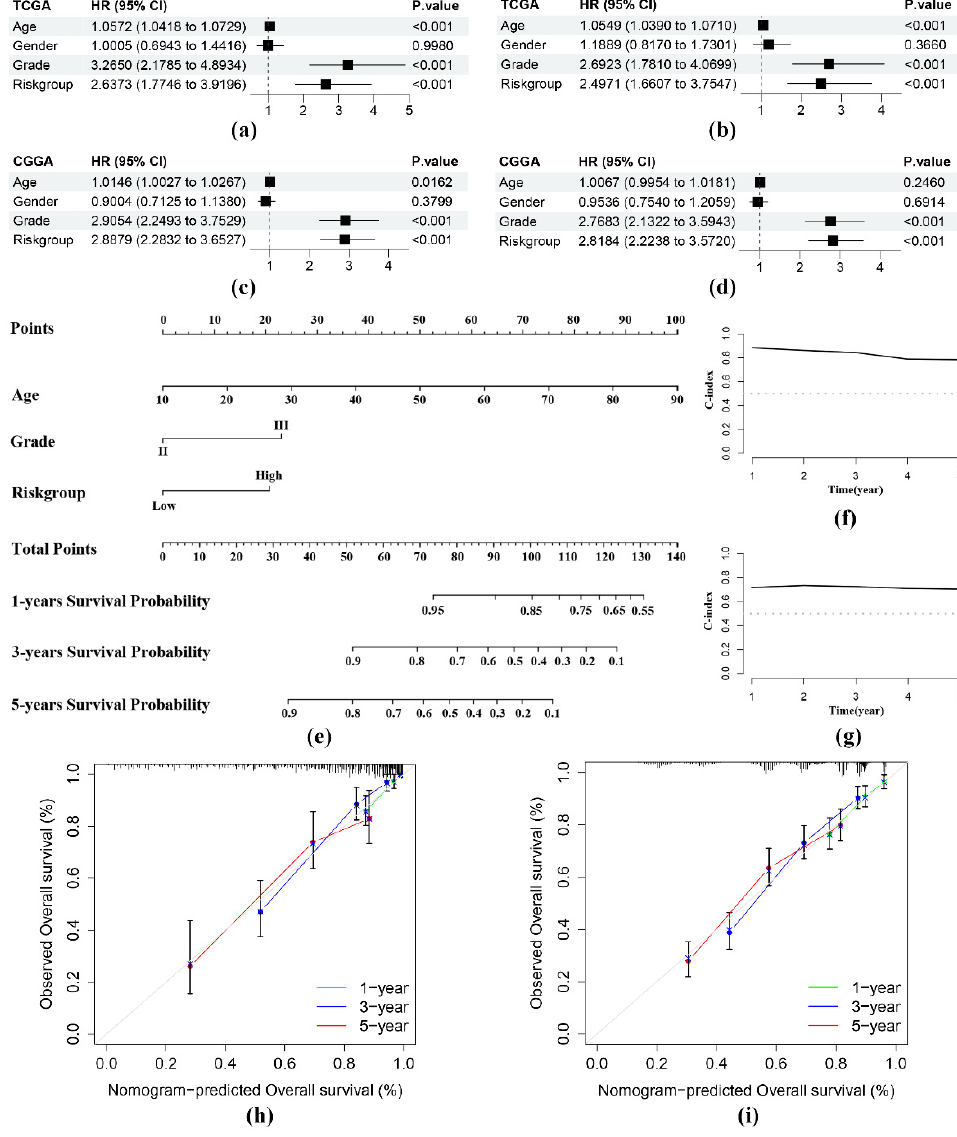
Figure 4. Evaluation of the predictive abilities of the nomogram. Univariable and multivariable Cox regression analyses of age, sex, grade, and risk group in the TCGA ( a , b ) and CGGA ( c , d ) cohorts. ( e ) Prediction of 1-, 3-, and 5-year OS in patients with WHO grade II/III gliomas by utilizing the nomogram. ( f , g ) Time-dependent C-index plots of the nomogram in both cohorts. ( h , i ) Calibration curves of the 1-, 3-, and 5-year OS in both cohorts for the nomogram.